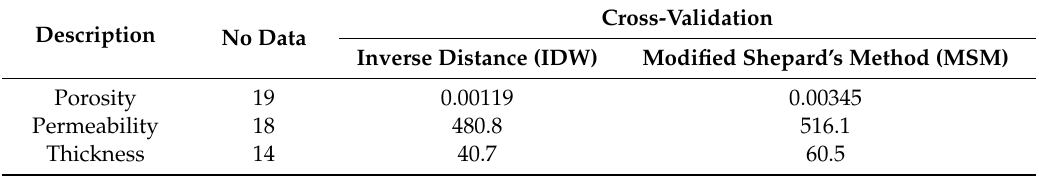
Table 3. Cross-validation (MSE) of the IDW and MSM methods applied in reservoir "K" [43].